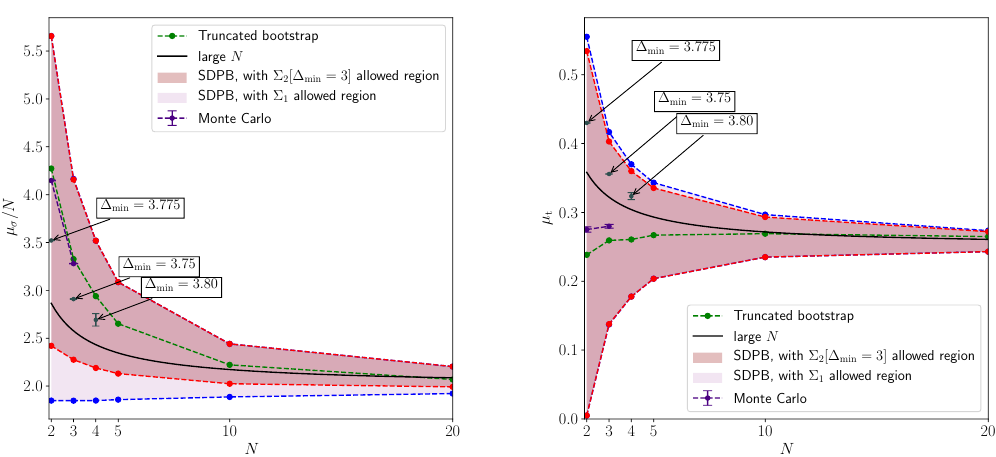
Figure 7: Bounds on the OPE coefficients µ σ and µ pared with truncated bootstrap, Monte Carlo (table 2) and perturbative results. The lightly shaded regions bounded between the blue lines represent the runs with ∆ = ∆ ε , whereas the dark shaded regions between the red lines represent the min stricter bounds from eq. (50). The solitary data points in grey are the improved lower bounds for µ σ and upper bounds for µ